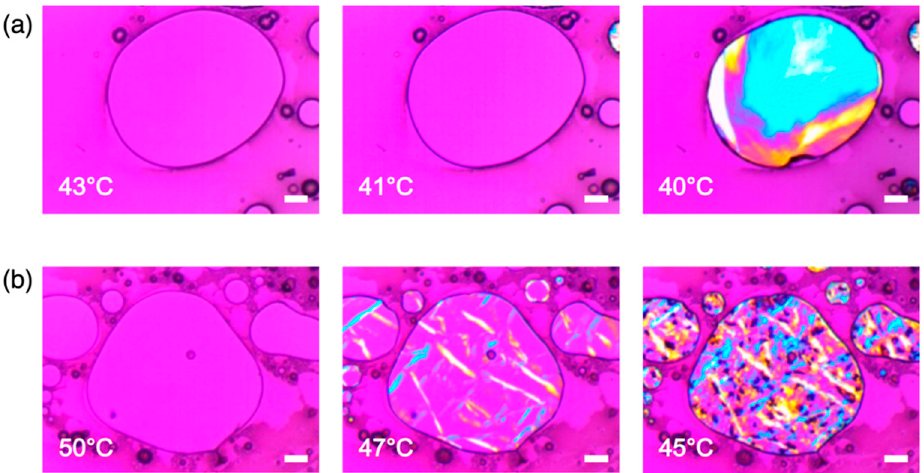
Figure 3. OM micrographs of IBU/OD mixtures at the compositions of IBU/OD ( a ) 5:5 (eutectic mixture) and ( b ) 2:8. Cooling crystallization behaviors were shown under cross polarization. All scale bars are 100 μ m.